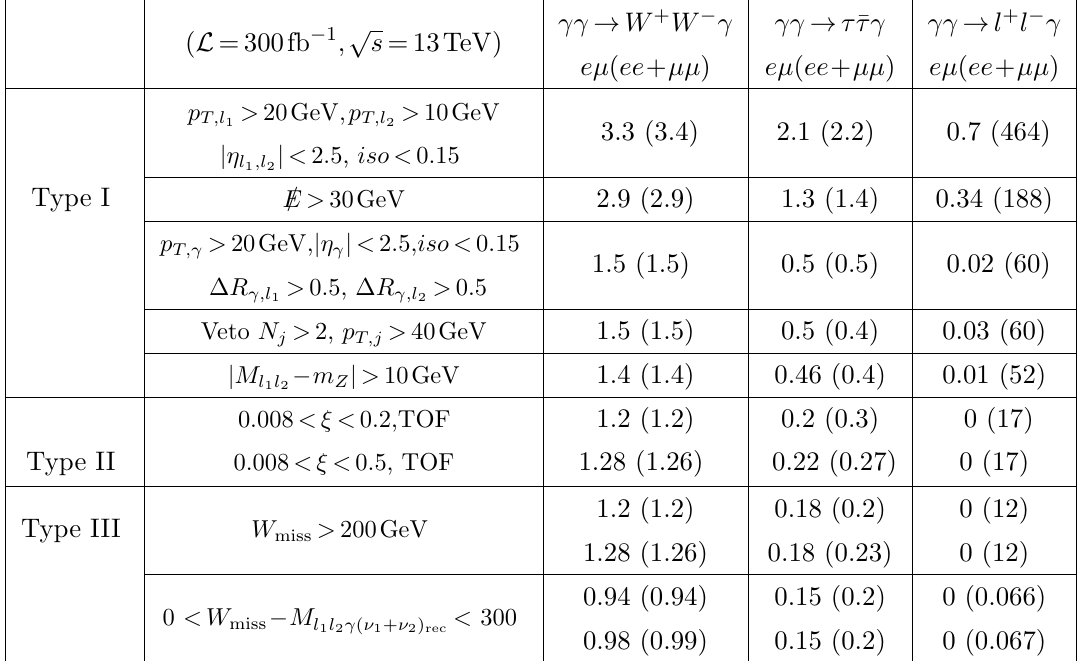
Table 3 . The remaining yields of the SM (cid:13)(cid:13) ! W + W (cid:0) (cid:13) , (cid:13)(cid:13) ! (cid:28) + (cid:28) (cid:0) (cid:13) , and (cid:13)(cid:13) ! e + e (cid:0) (cid:13)=(cid:22) + (cid:22) (cid:0) (cid:13) after each type of selection cuts for 300fb (cid:0) 1 IL are